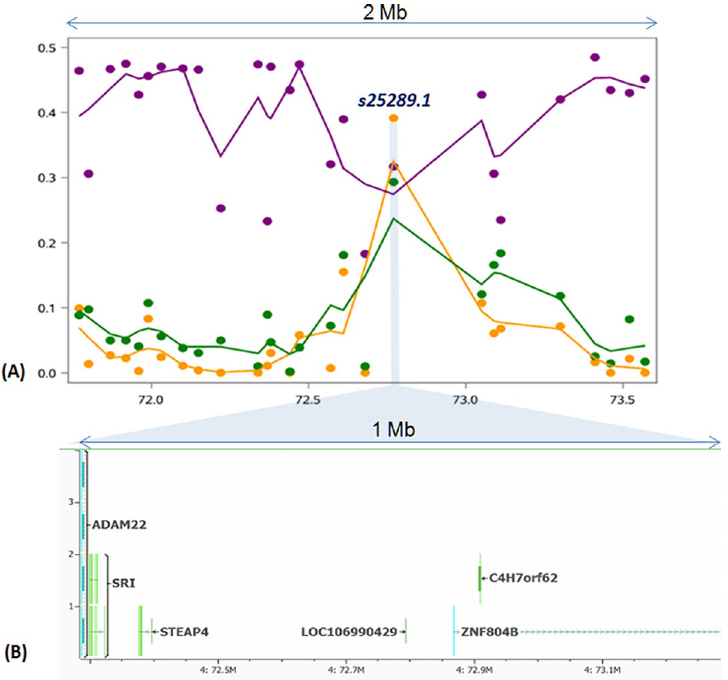
Fig 5. (A) Loess curves of F ST (orange line), within diversity (purple line) and between diversity (green line) for 1 Mb genomic distances around the F ST outlier marker (s25289.1). Smoothed lines were obtained via LOESS procedure in SAS (ver.9.4) using a smoothing parameter equal to 0.21 for the three variables and 27 points (markers) (B) Positional candidate genes within 500 kb down- and up-stream the significant marker (s25289.1) are also shown